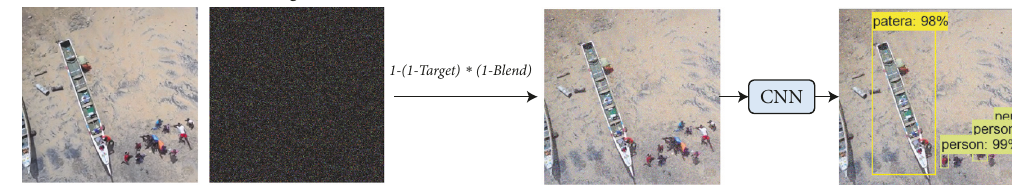
Figure 12: Random Gaussian noise